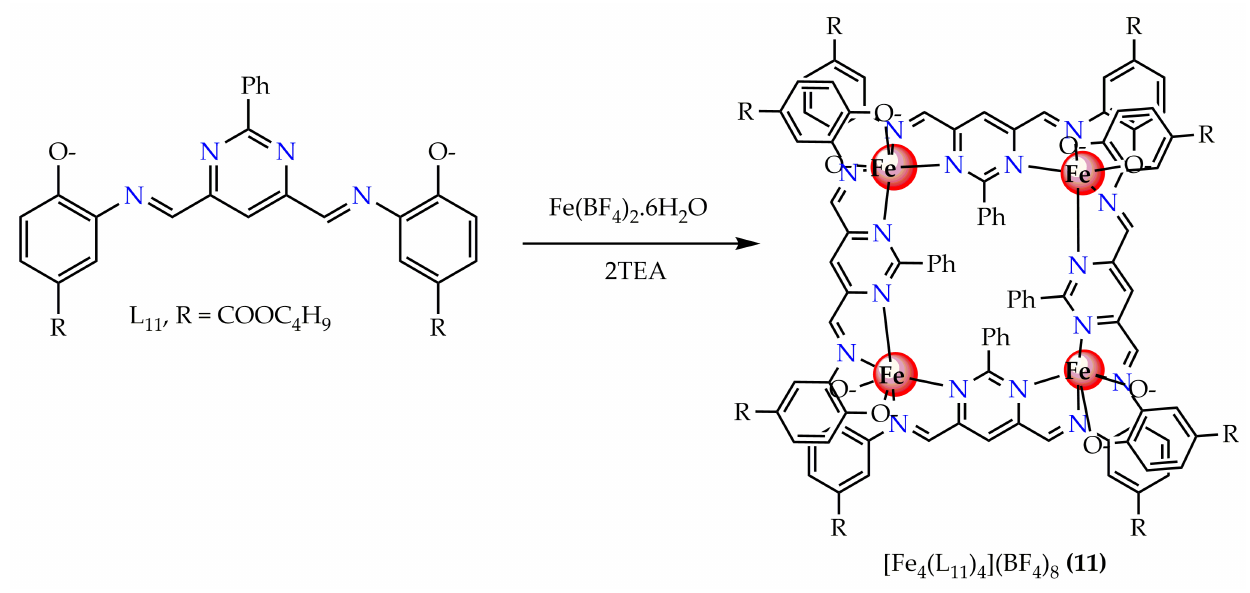
Scheme 2. Self-assembly of the [2 × 2] grid-type complex from ligand L 11 components and iron(II) ions. Reproduced from [87]; published by Wiley, 2009.